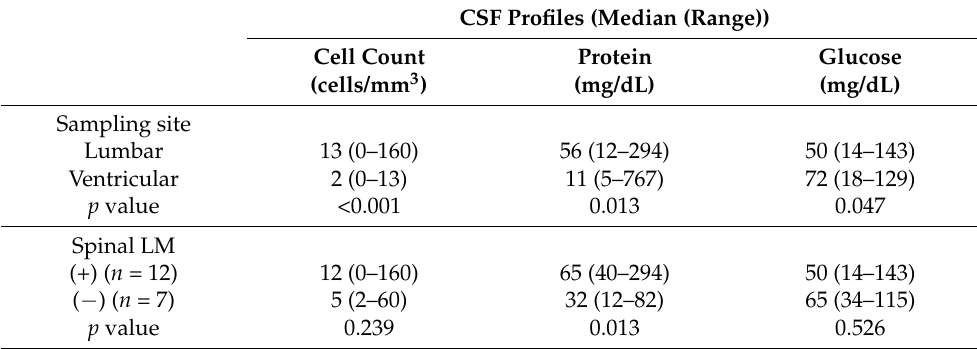
Table 2. Differences of CSF profiles according to the sampling site and spine MRI finding of LM ( n =